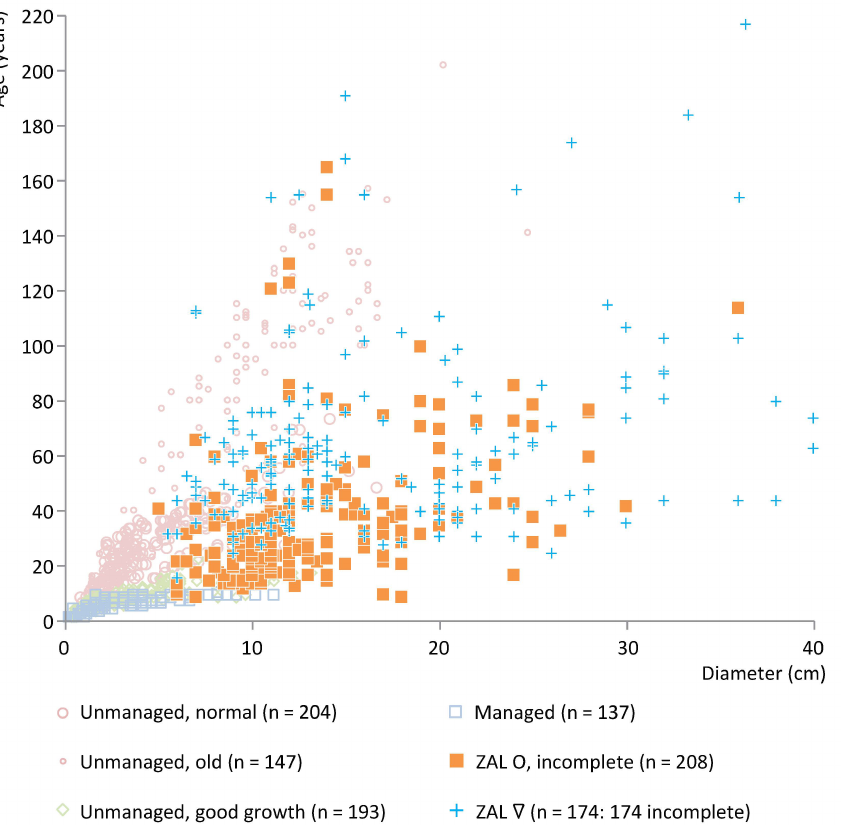
Figure 10. Oak posts from Založnica, cluster KK, plotted against a representative selection of modern oak reference data. O = roundwood, ∇ = split